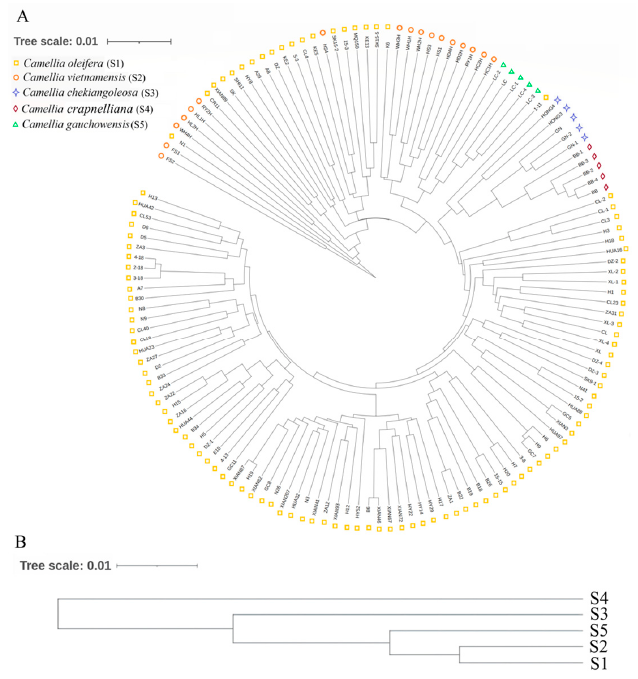
Figure 3. The UPGMA phylogenetic tree of oil-tea camellia samples based on SSR data. ( A ): The phylogenetic tree of 140 samples; ( B ): The phylogenetic tree of five Camellia species.